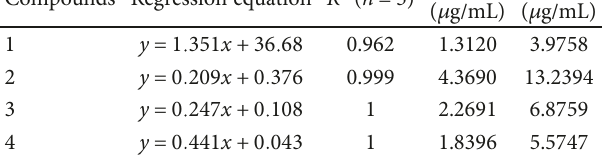
Table 1: Calibration curves, LOD, and LOQ of four compounds in N. nucifera embryos. Neferine (1),